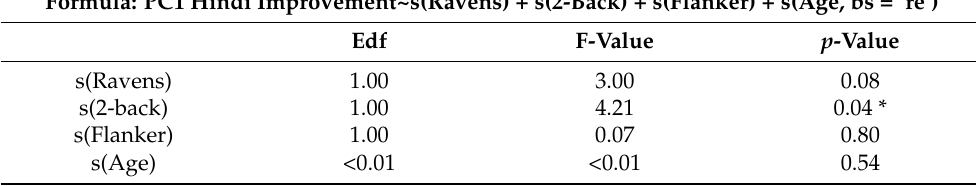
Table A5. Output of the generalized additive model for the Hindi literacy improvement.